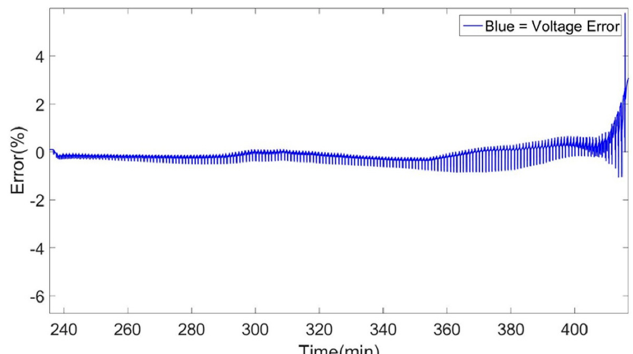
Figure 13. 1st order Thévenin model measured and simulated DDP comparison at 25 °C with Coulomb counting and advanced characterization.